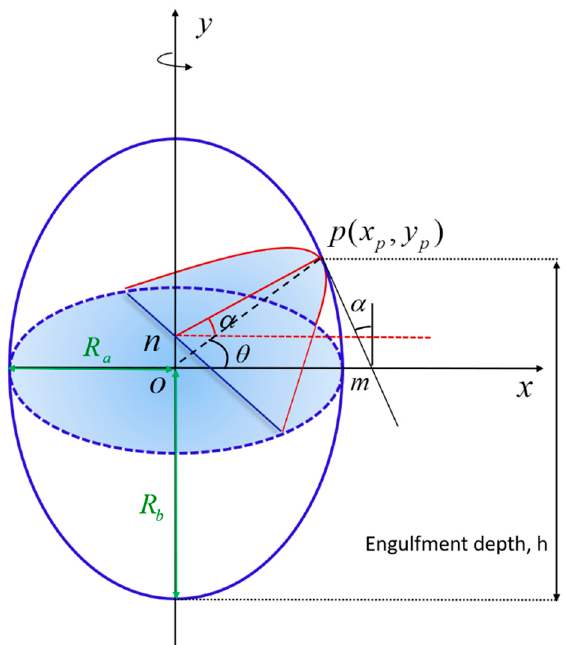
Figure A1. Geometry and coordinates of an ellipsoid.